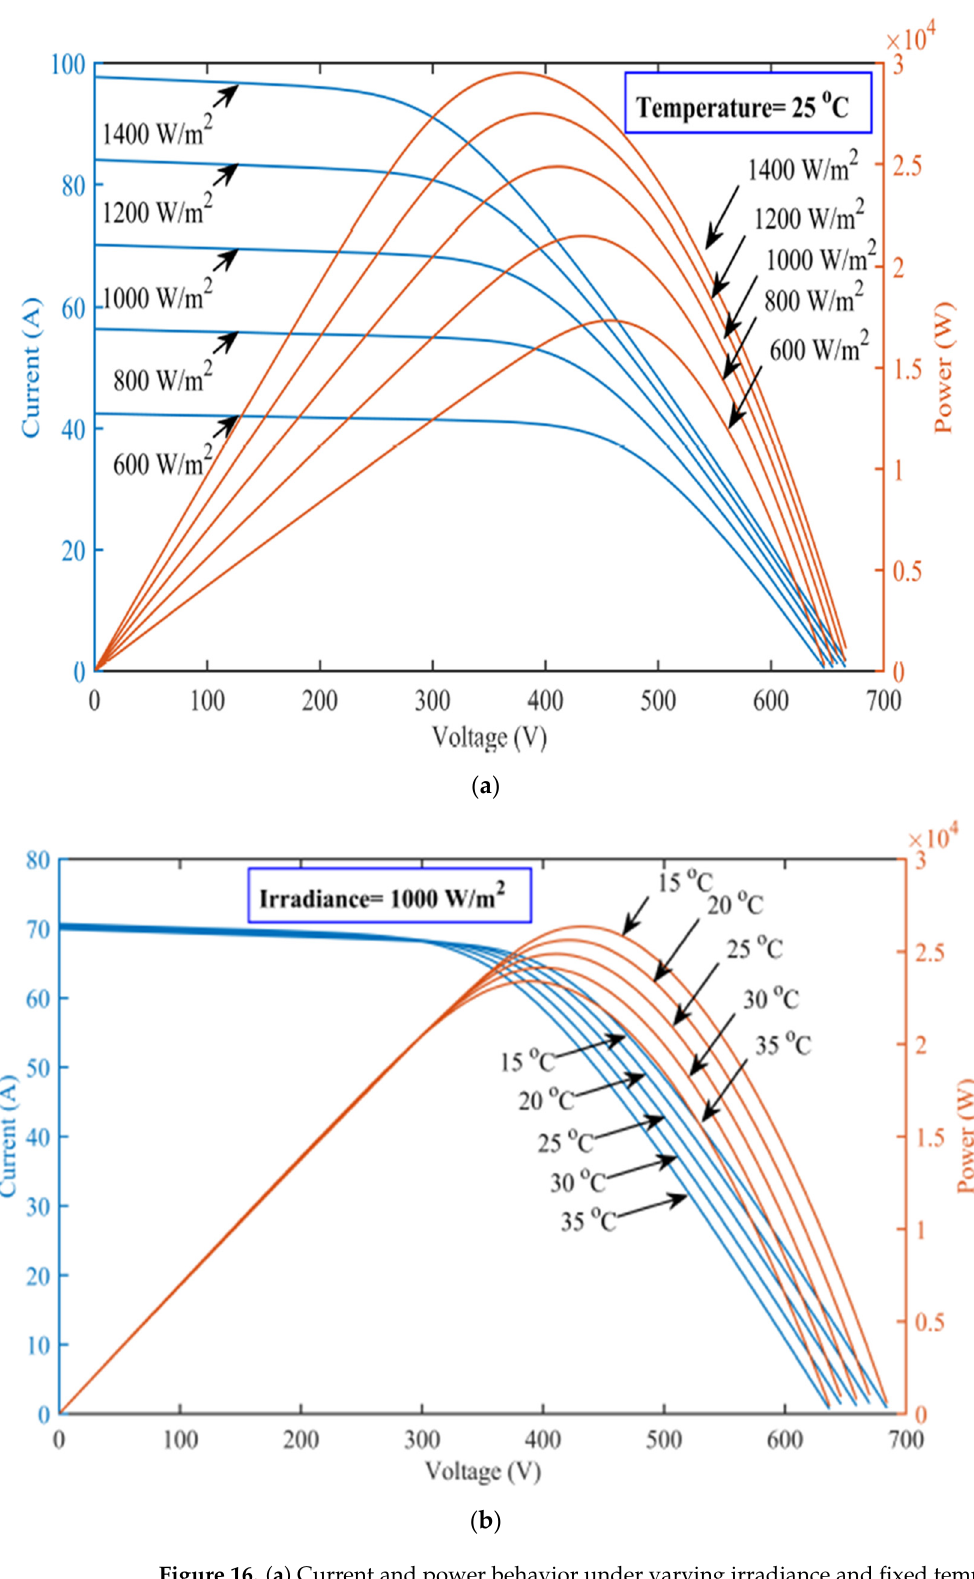
Figure 16. ( a ) Current and power behavior under varying irradiance and fixed temperature of 25 °C . ( b ) Current and voltage behavior under varying temperature and fixed irradiance of 1000 W/m 2 .